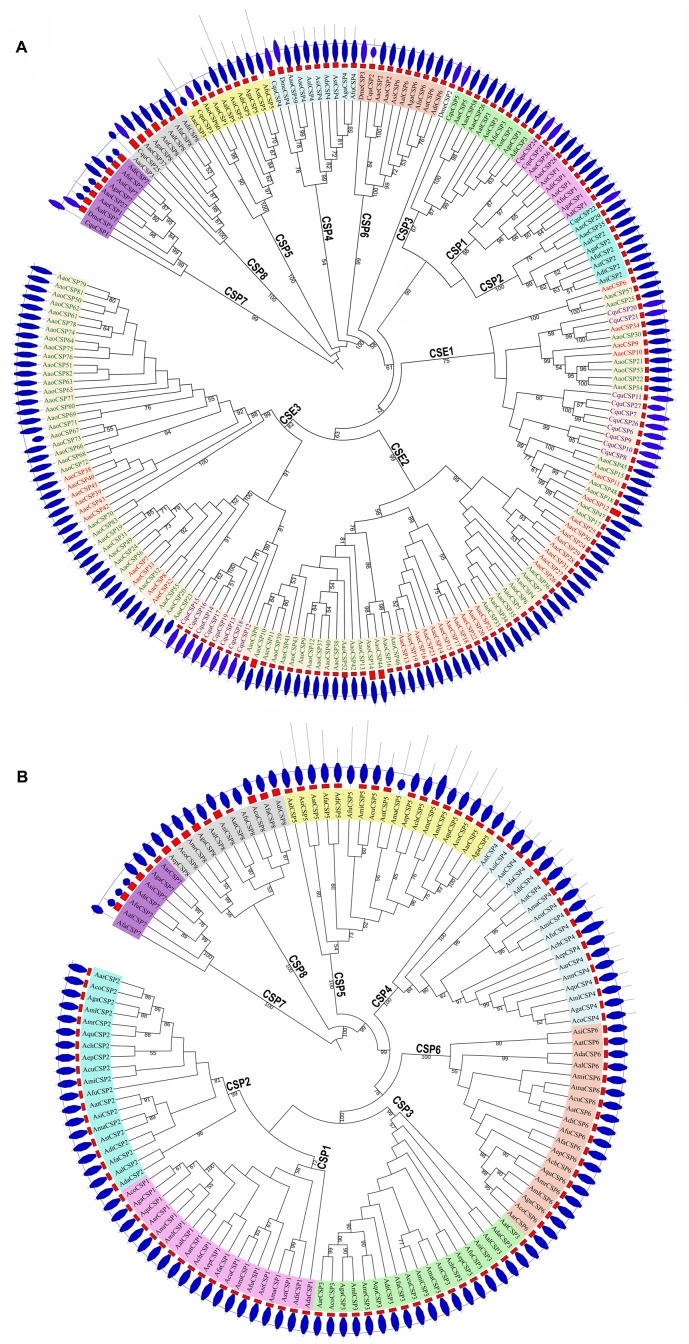
Phylogeny of the CSP aa sequences of 22 mosquito species and D. melanogaster.A) Phylogeny of CSP genes in six representative Anopheles species, three Culicinae species, and D. melanogaster. B) Phylogeny of CSP genes in all 19 Anopheles species. ML phylogenetic trees were constructed using the WAG (Whelan and Goldman) model, as selected by ModTest. Bootstrap values were calculated using 1000 replications. Bootstrap values ≥50% are marked on branches. The most outed layer of blue octagon denotes the position and size of the domain OS-D. The second outed layer of red rectangles shows the signal peptide and its relative size. CSP: Shared CSP groups; CSE: Culicinae-specific expanded CSP groups. In the CSE groups, CquCSPs are shown in purple, AaeCSPs in red, AaoCSPs in green. In the CSP groups, Anopheles CSPs are shown in black.